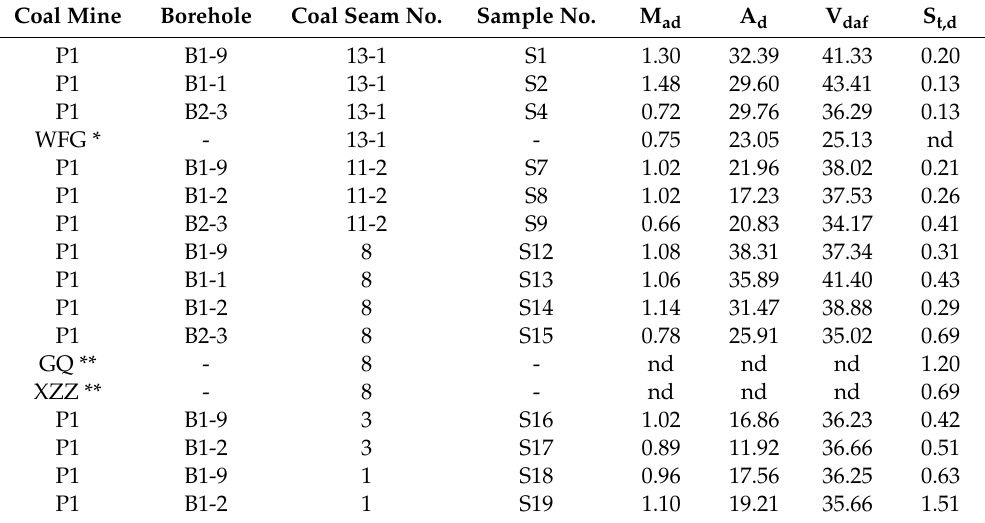
Table 1. Proximate analyses (%) and total sulfur (%) of the coal samples from the Huainan coalfield. Coal Mine Borehole Coal Seam